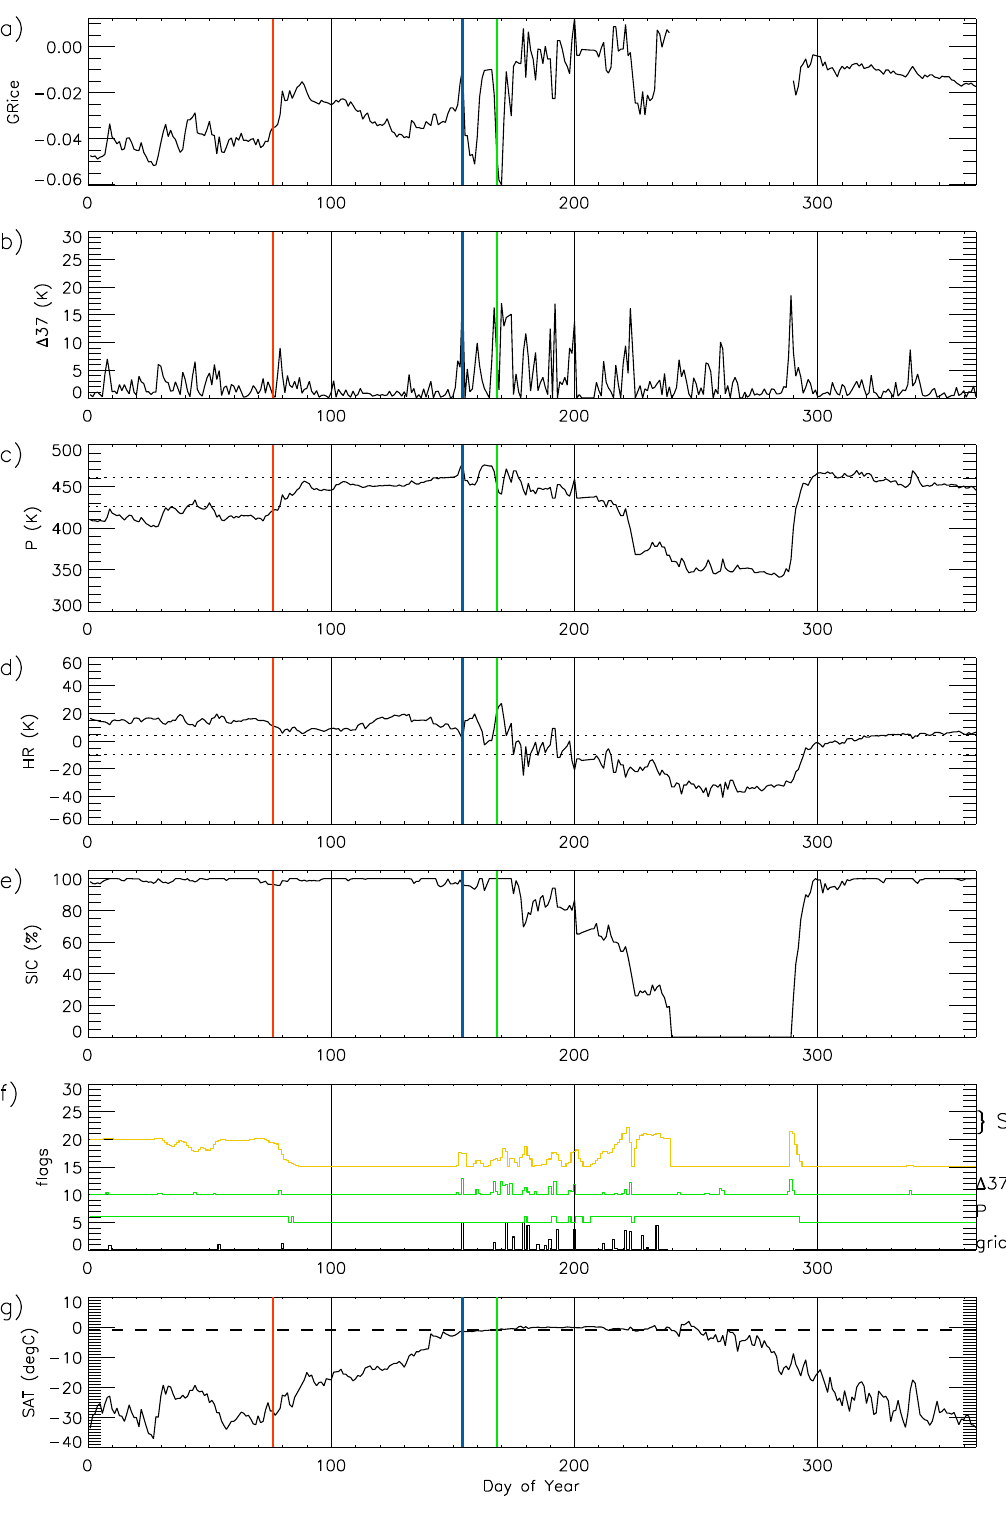
Figure 3. PMW MO parameters (( a ) Δ GR ice , ( b ) Δ 37V, and ( c ) P), ( d ) AHRA HR, ( e ) NASA Team sea ice concentration, ( f ) PMW weighting flags (see text for details), and ( g ) POLES SAT from 1995 for case study location in the Laptev Sea (79.7°N, 121.4°E). MO dates from AHRA (blue), PMWC (red), and first instance of SAT >0 °C (green) are shown as vertical lines.